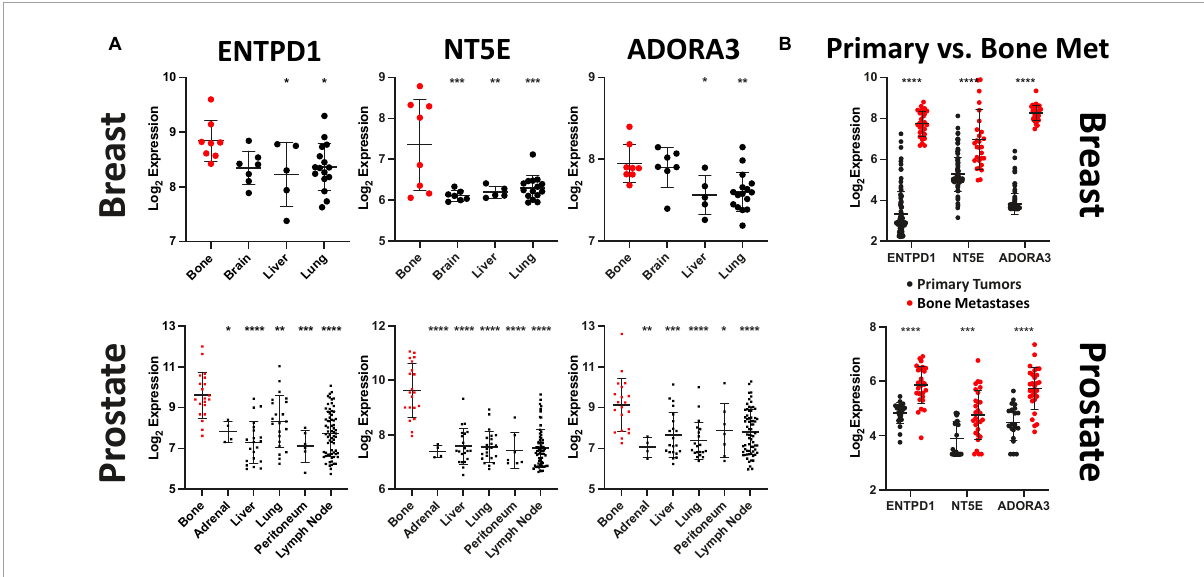
FIGURE3 ENTPD1, NT5E, and ADORA3 expression are much higher in bone metastases than in other metastases or primary tumors. (A) Relative expression of ENTPD1, NT5E, and ADORA3 in metastatic breast and prostate tumors in various organs in GEO datasets GSE14020 and GSE74685. We found that ENTPD1, NT5E, and ADORA3 tend to be more highly expressed in breast and prostate cancer bone metastases (red) than in metastases to other sites (black). (B) We found significantly higher expression of ENTPD1, NT5E, and ADORA3 in bone metastases (red) than in primary breast (black, GSE47561) or prostate (black, GSE32269) cancers. One-way ANOVA with Dunnett’s post-test was used in (A) and unpaired Student’s t -test was used in (B) . * p < 0.05; ** p < 0.01; *** p < 0.001; **** p < 0.0001.